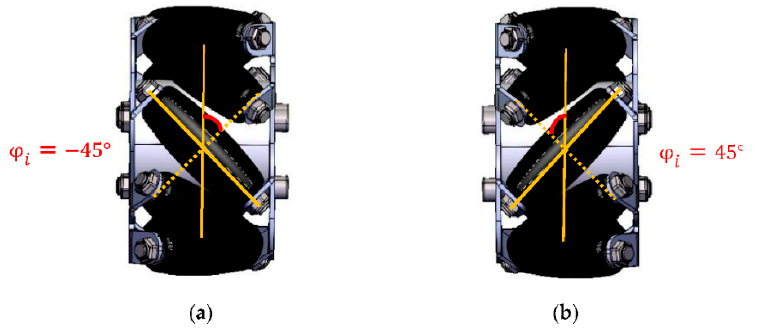
Figure 3. Mecanum wheel design: ( a ) Left mecanum wheel; ( b ) Right mecanum wheel.